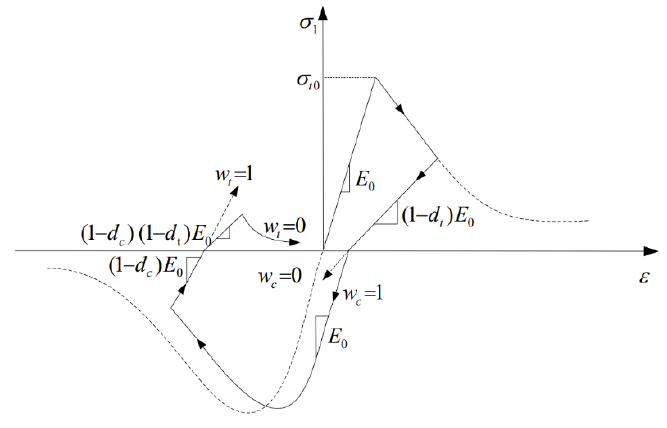
Figure 1. Stress–strain relation under the uniaxial alternating load.